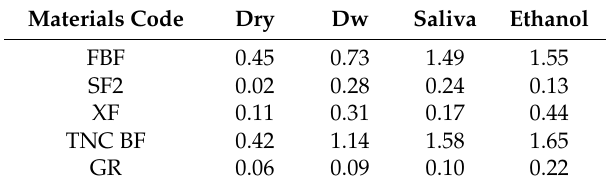
Table 4. Permanent set %.